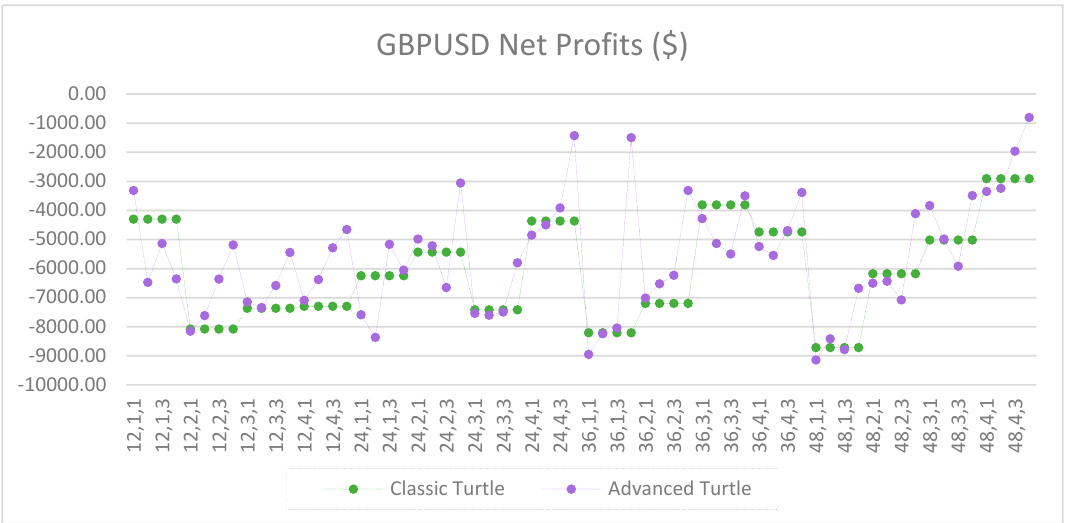
Figure A21. Net profits of GBPUSD between the classic and the advanced Turtle systems for every combination of N, X, Y for the medium parameters (40, 80).